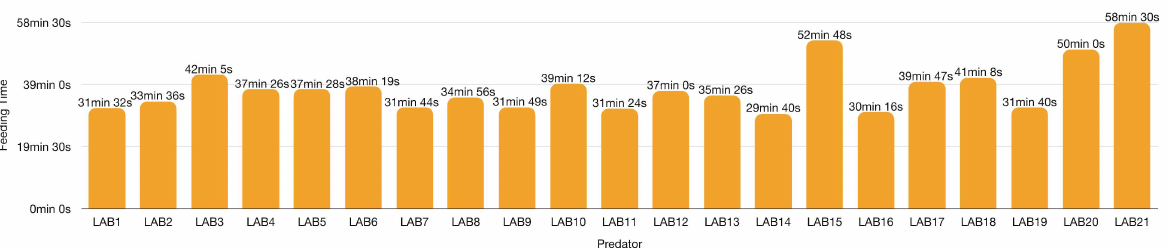
Figure 12. Zelus renardii individual average feeding time per 15 hemipterans (Aphrophoridae, Issidae and Miridae) prey, details in Table